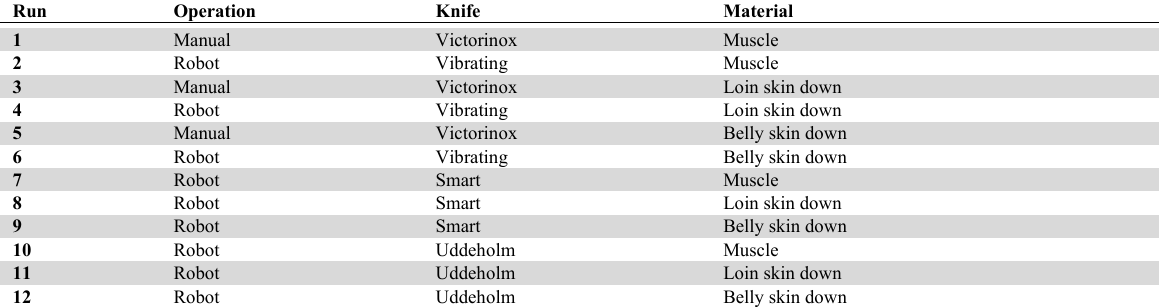
Design layout of the